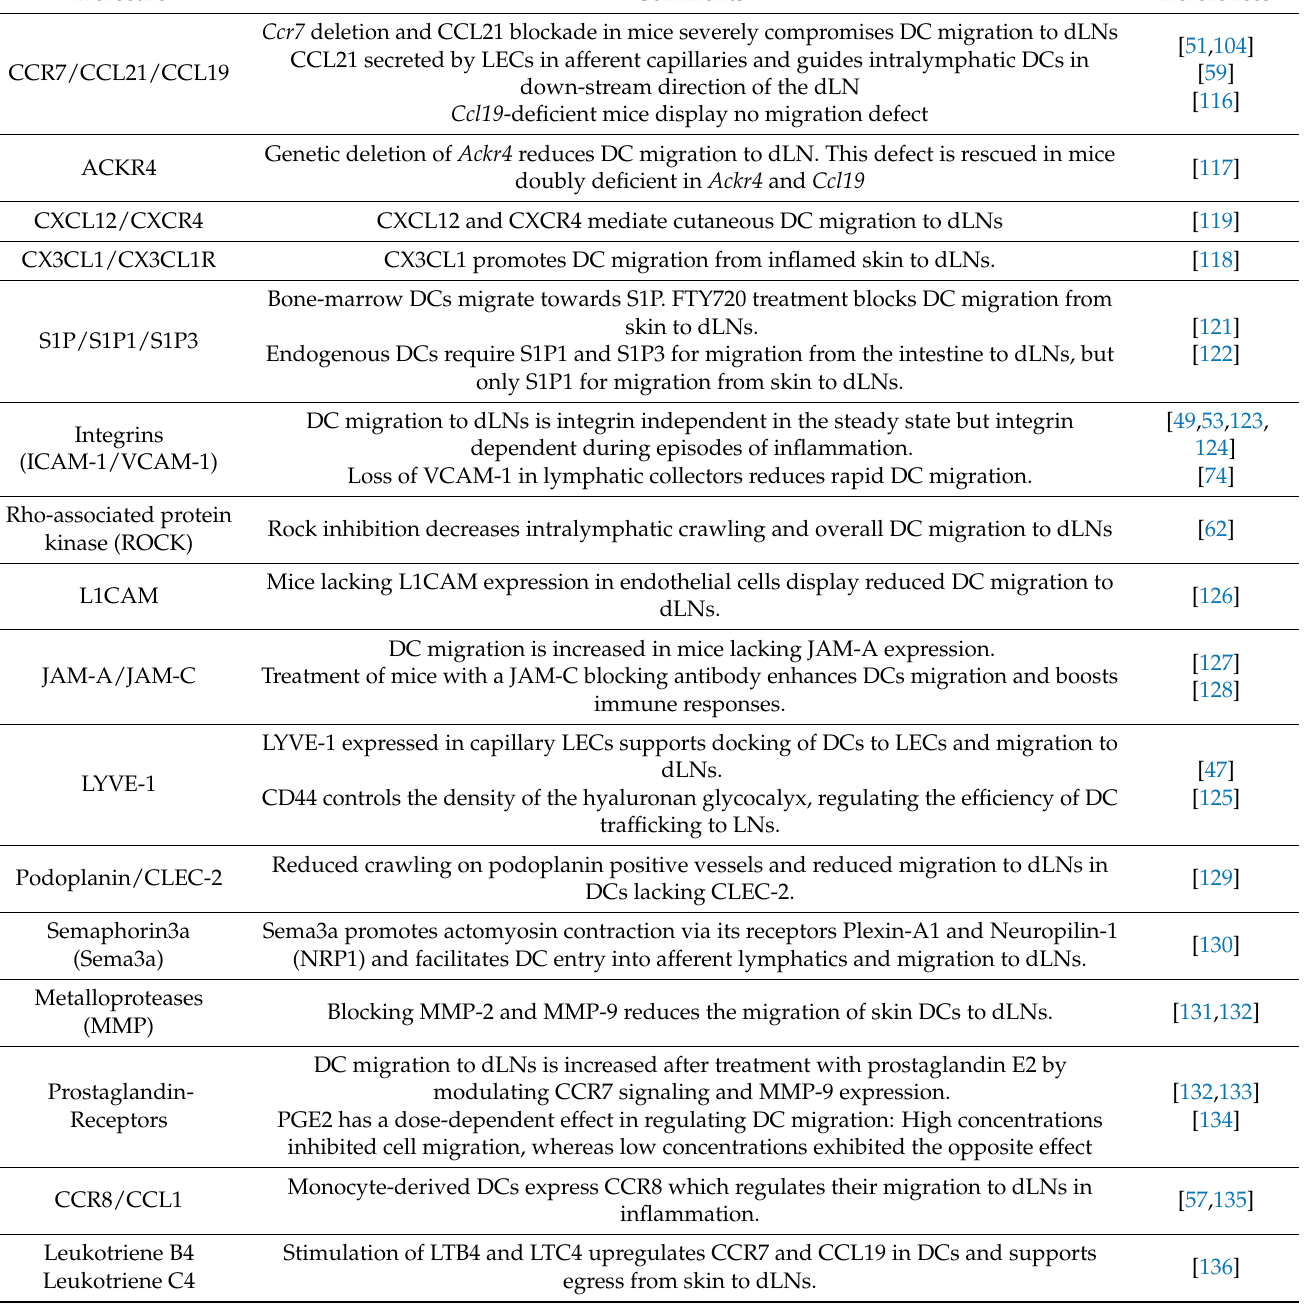
Table 1. Molecules involved in DC cell migration through afferent